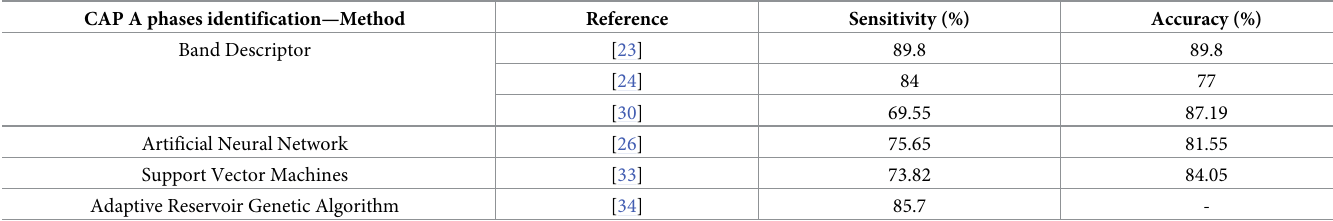
Table 1. Performance metrics in the articles